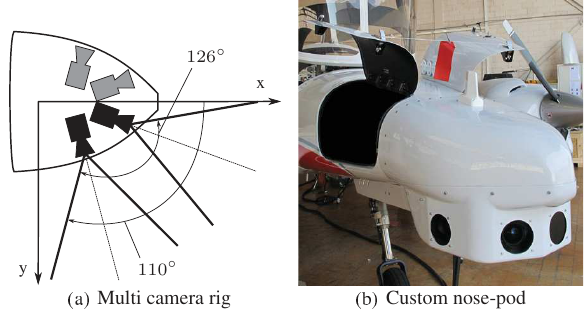
Figure 2: Overview of the multi camera rig in the sensor nose- pod. As shown in the left figure, only two of the possible four cameras are mounted in the pod which was sufficient to record the relevant collision scenarios and cover approximately half of the recommended field of view for a Detect and Avoid system [ASTM International, 2007]: ± 110 ◦ horizontally and ± 15 ◦ ver-